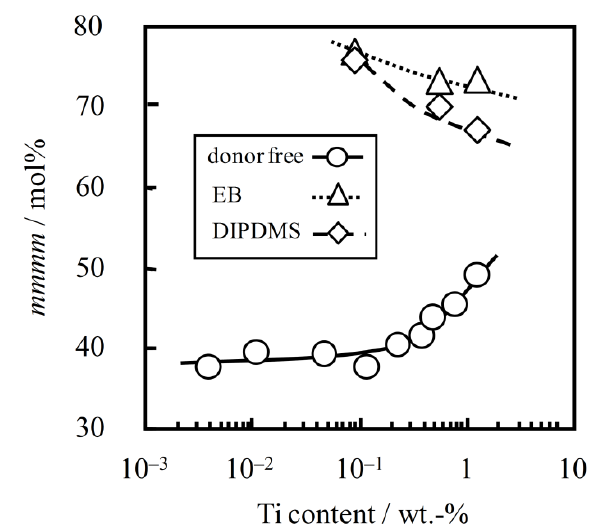
Figure 1. Stereoregularity of polypropylenes (PPs) produced by TiCl catalysts as a function of the Ti content with and without donors. Propylene polymerization at normal pressure was conducted at 30 °C in heptane with 1.25 mmol·L − 1 of triethylaluminum for 30